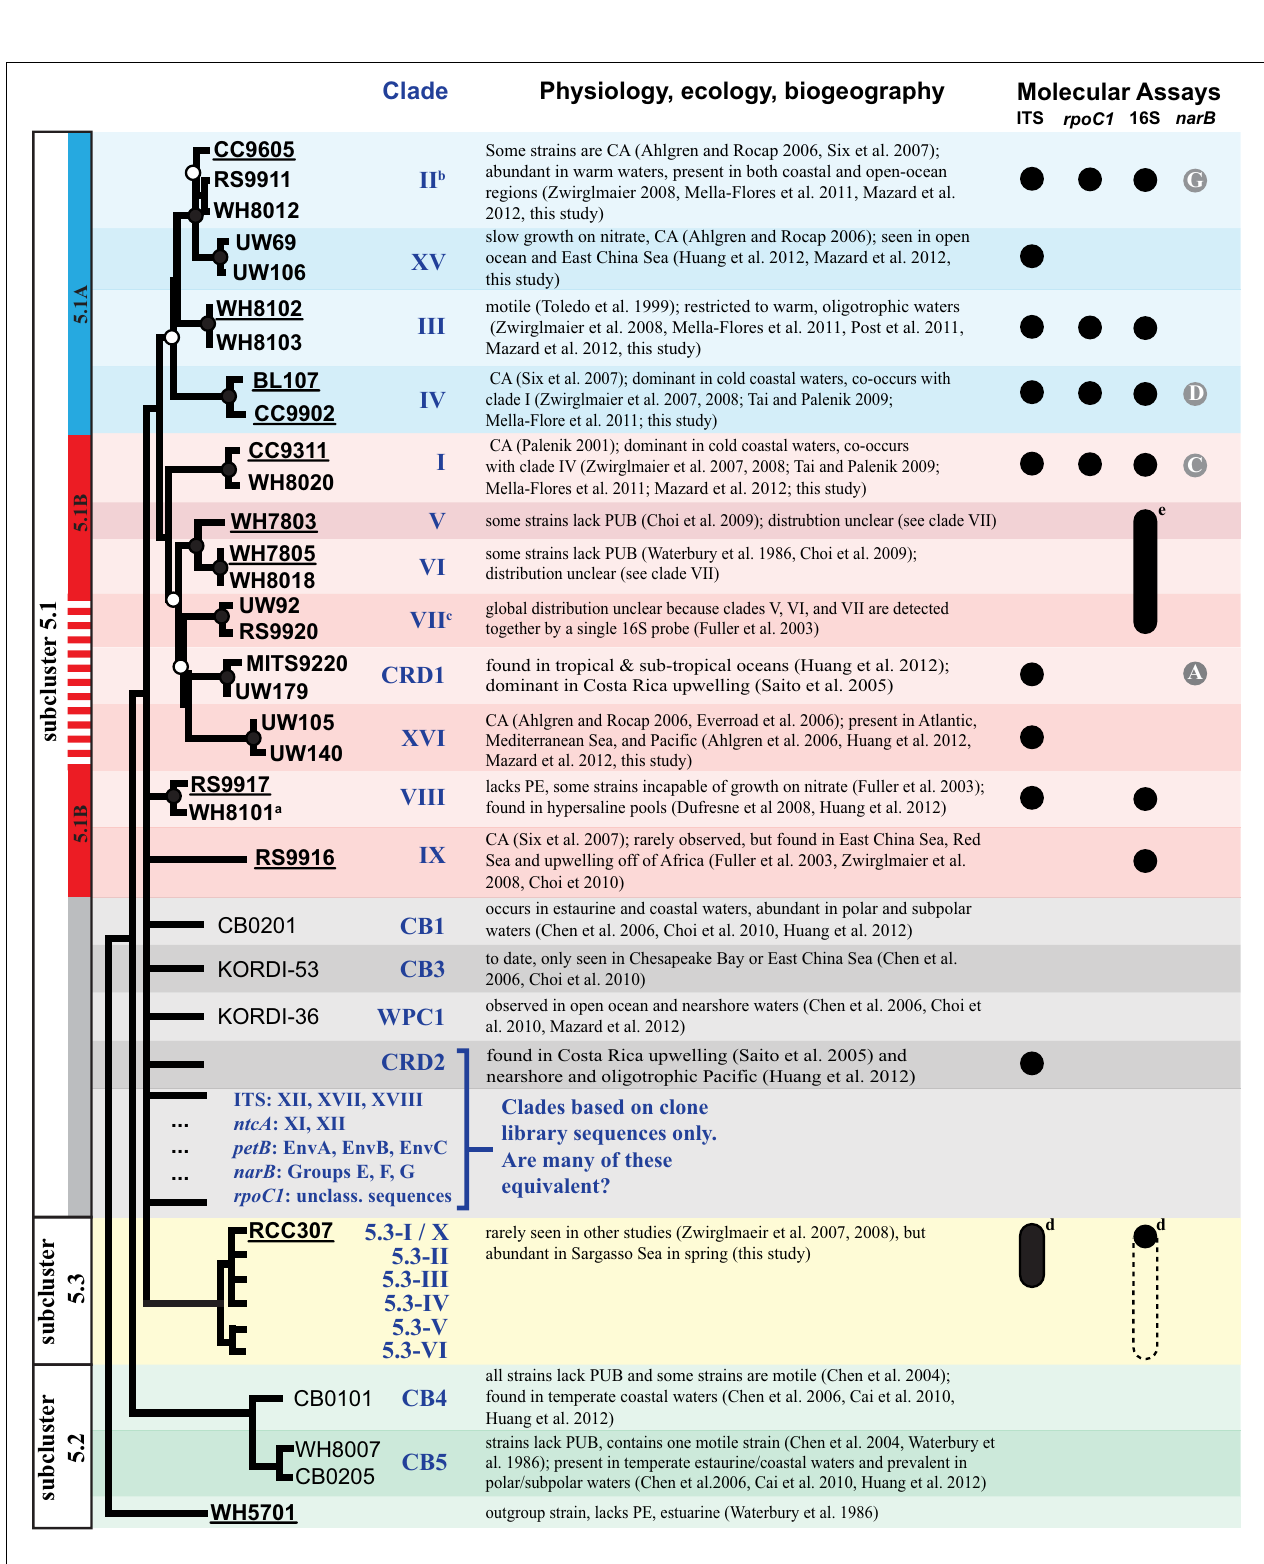
strains) in each clade are shown. Strains in bold were selected for multiple gene loci analysis, and strains with sequenced genomes are underlined. Branch tips without taxa names indicate clades that are only represented by environmental sequences (e.g., clade CRD2). Nodes with bootstrap